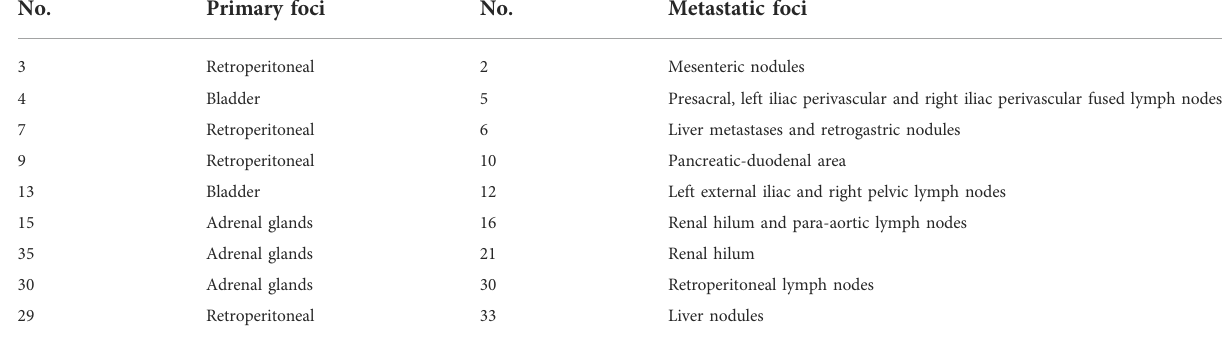
TABLE 5 Location of metastatic and primary foci.